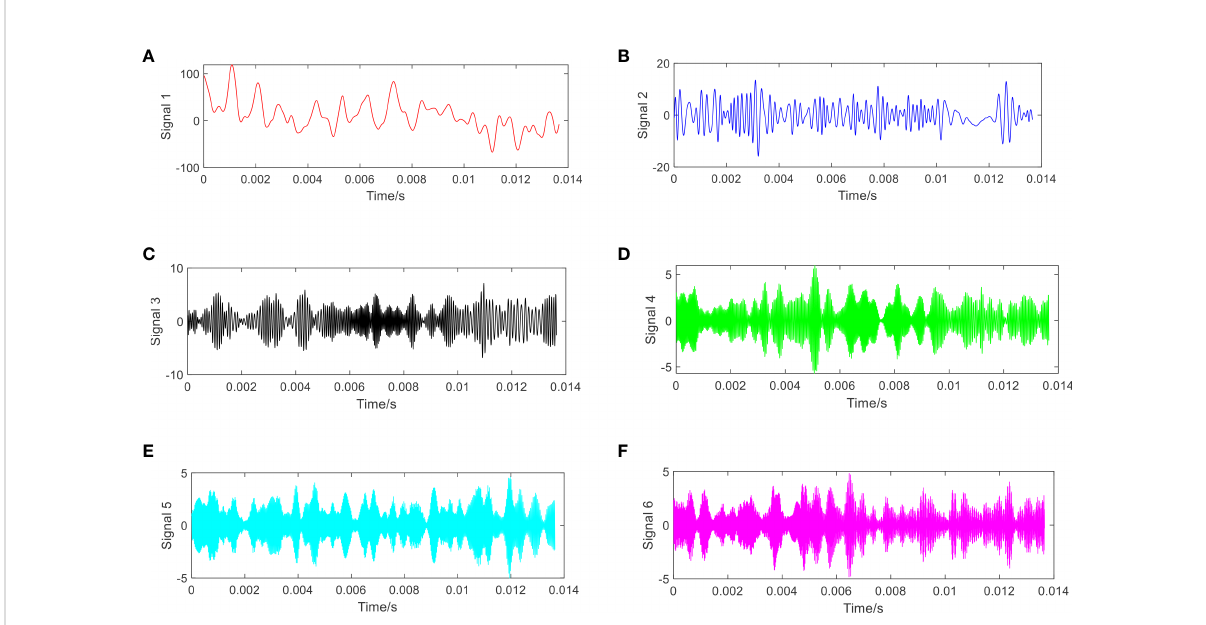
FIGURE 10 The decomposed signal components using the proposed approach. (A) Component 1; (B) component 2; (C) component 3; (D) component 4; (E) component 5; and (F) component